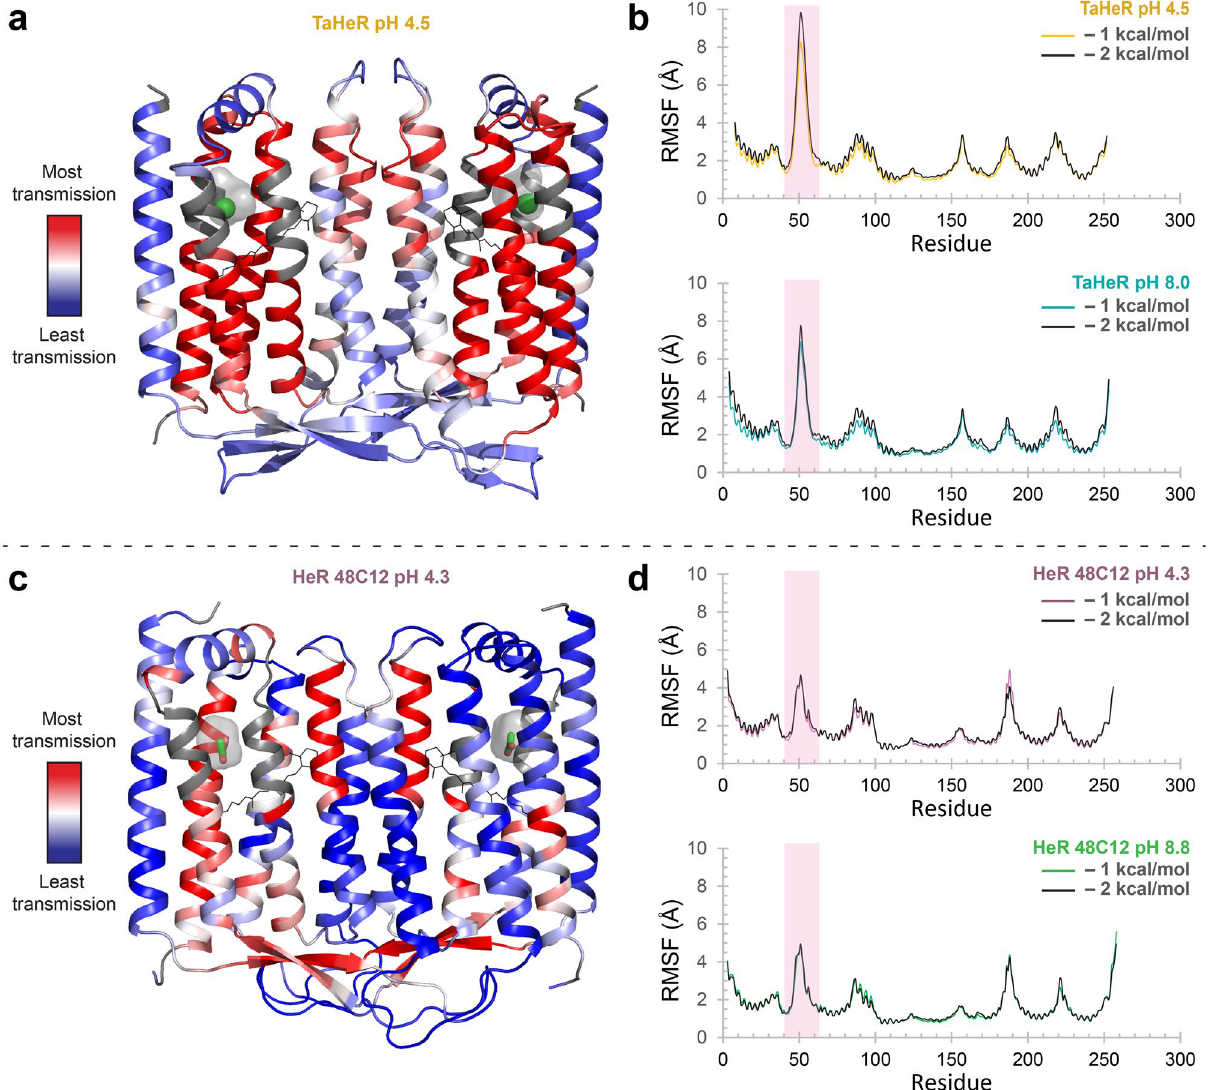
Figure 6. Allosteric transmission and conformational dynamics modelling in TaHeR and HeR 48C12 dimers. ( a , c ) The allosteric network within HeR dimers is revealed through rigidity theory allostery analysis. Allosteric transmission is measured by changes in conformational degrees of freedom (red/blue gradient bar) experienced upon rigidification of the negatively charged ion (chloride or acetate, green) occupying the SBC (grey surface) of the acidic pH structure. Amino acids within 3 Å of the charged ion (grey portions of the helix) were omitted from the coloring scheme to prevent skewed coloring biases, as neighbouring residues would naturally have high allosteric effects. ( b , d ) Constrained geometric Monte Carlo-based dynamics analysis predicts individual residue dynamics measured as the root mean squared fluctuation (RMSF). The extracellular β-sheet (A–B loop) that was further on investigated by DEER is highlighted in